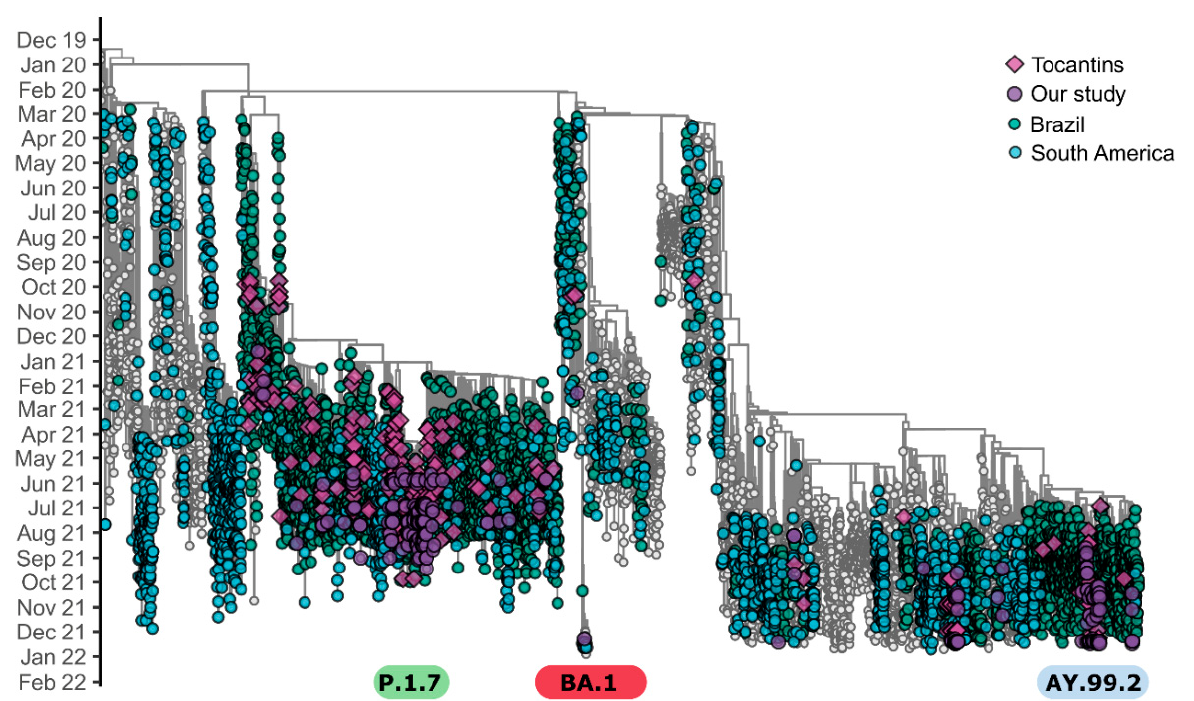
Figure 5. Time-resolved maximum-likelihood tree of 9493 SARS-CoV-2 genomes. Tips are colored by the most frequent Pango lineages. Diamonds represent Tocantins genomes.